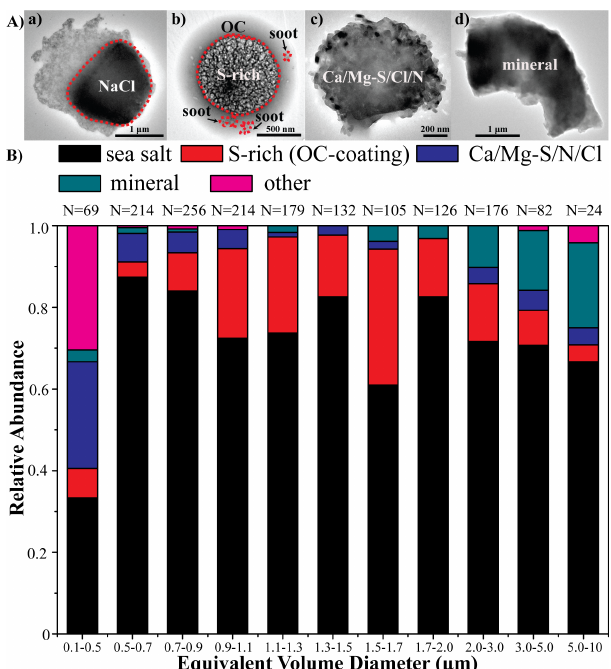
Figure 1. Morphology and relative abundances of typical individual aerosol particles in summertime Arctic samples: (A) TEM images of four types of aerosol particles, (B) relative abundances of dif- ferent particle size ranges. The number of the analyzed particles in different size ranges is shown above each